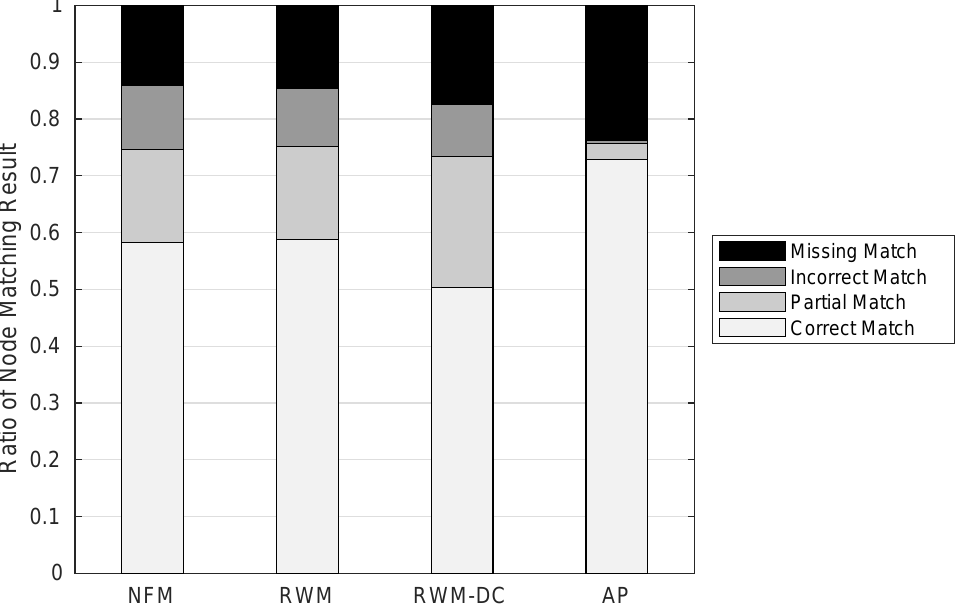
Figure 13. Ratio of node matching